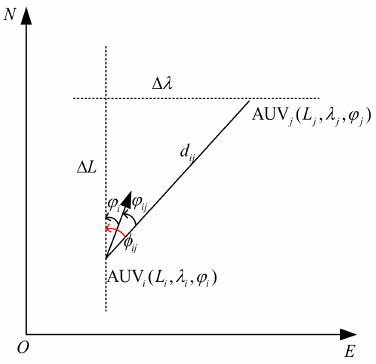
Figure 2. Mutual observation of multiple